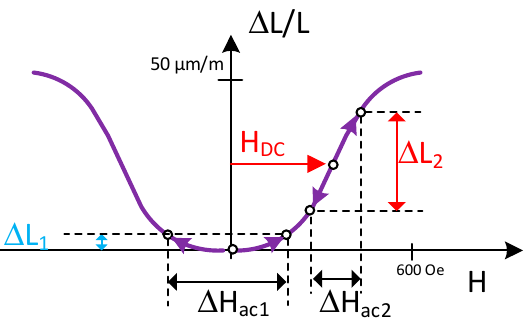
Figure 3. Magnetostrictive behavior.